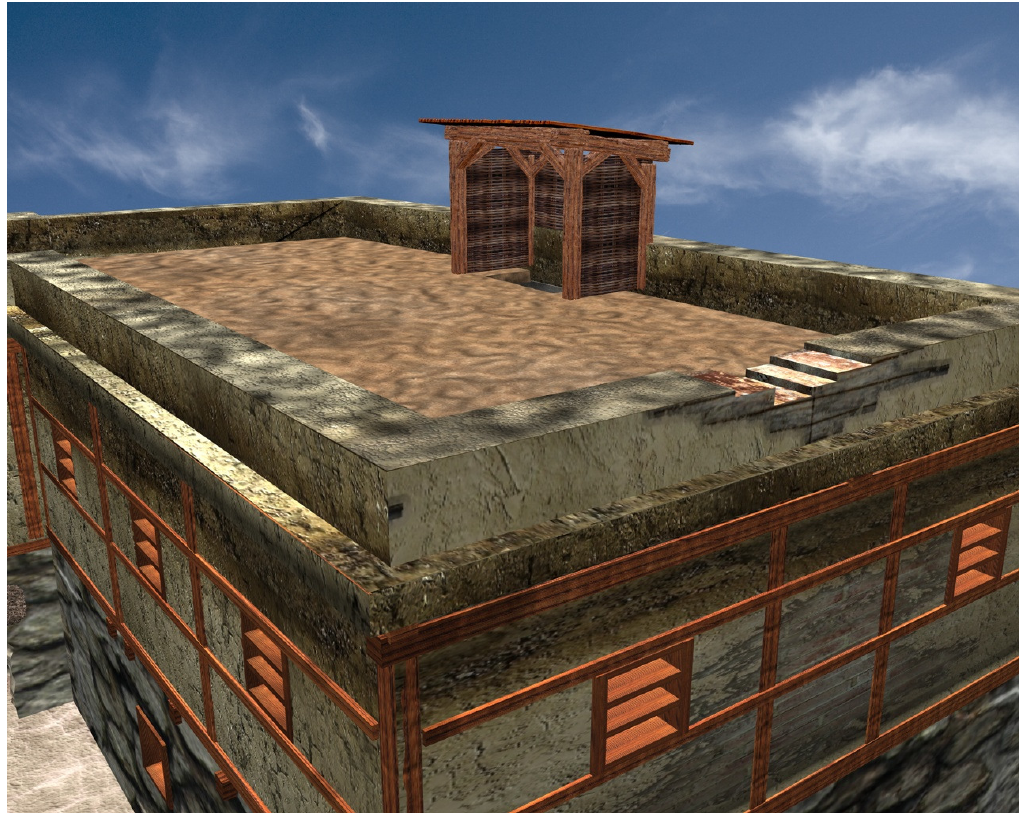
Figure 6. The roof of Building I (closed/walled variety), with the low balustrade and covered access hole. Created in Cinema